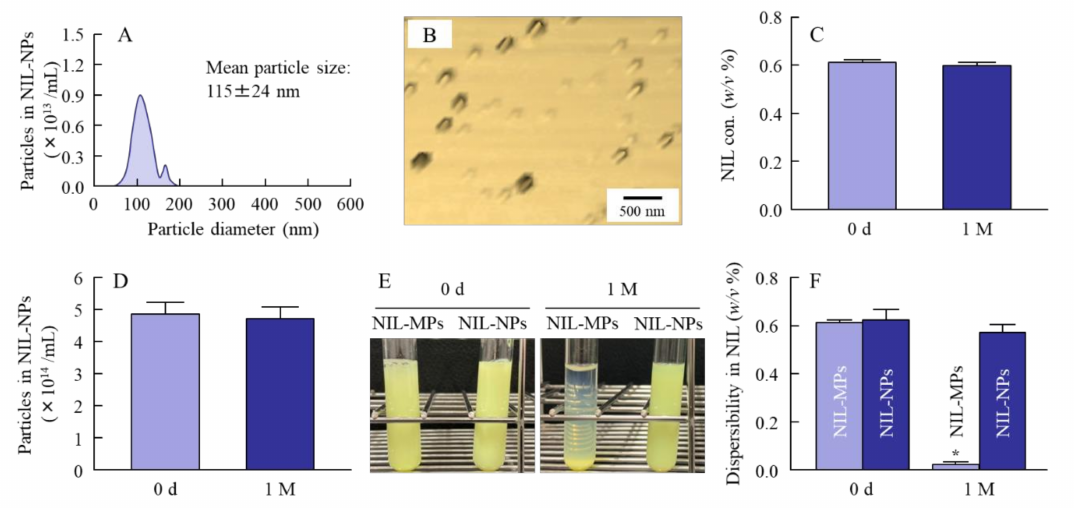
Figure 4. Drug stability of NIL-NP dispersions 1 month after preparation at 22 ◦ C. ( A ) Particle size frequencies of